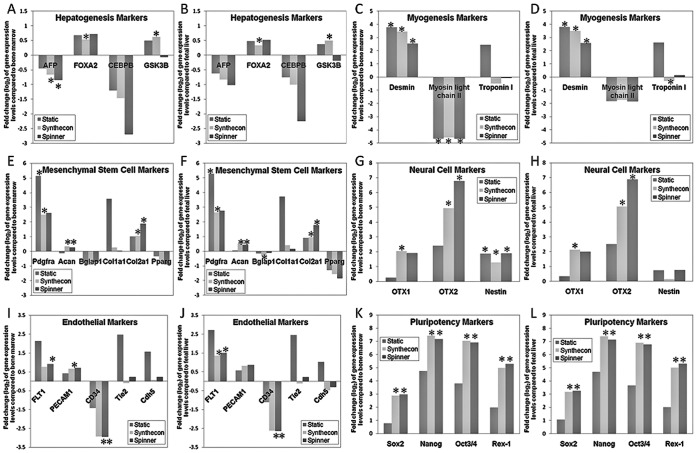
Differences in LKS cell gene expression.Fold changes of lineage-specific genes differentially regulated in Lin-ckit+Sca-1+ cells derived from Static and bioreactor culture conditions (Synthecon and Spinner flask) as compared to LKS cells derived from BM and FL. Expression levels (n = 3) were compared for genes representative of hepatogenesis (A, B), myogenesis (C,D), mesenchymal stem cells (MSC; E,F), neuronal cells (G,H), endothelial lineage (I,J) and transcriptional regulators of pluripotency (K,L). Under all ESC conditions we observed up-regulation of the hepatogenesis transcription factor, Foxa2 (A,B), the myogenesis intermediate filament, Desmin (C,D), several neuronal markers (G,H), and the majority of MSC markers (E,F). Expression of transcriptional regulators of pluripotency (K,L) were reduced most significantly under Static culture conditions. (*) represent gene-expression values of statistical significance (p<0.05).